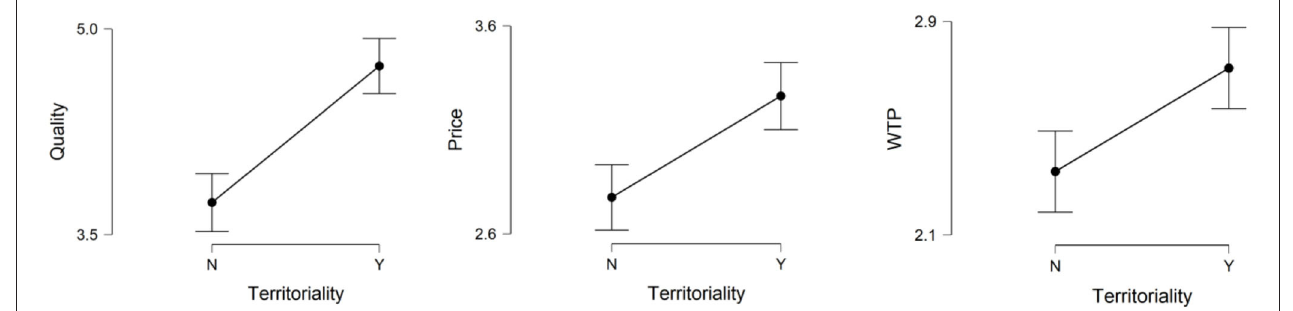
FIGURE 1 | Plot 1 – quality, price, and WTP /territoriality relation.